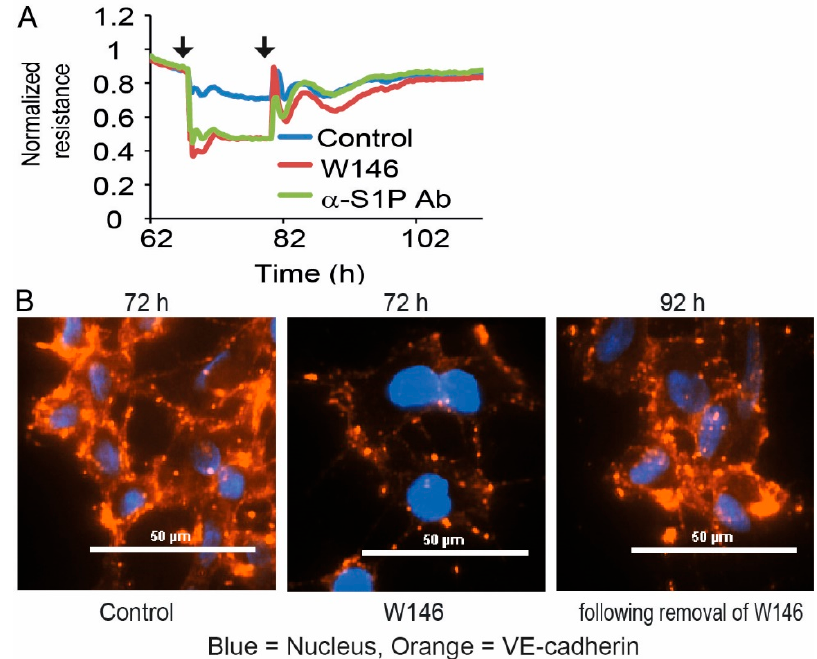
Figure 3. Dependence and reversibility of EC barrier stability in HUVEC and EA.hy926. ( A ) Resistance following treatment with 3 µ M S1PR1 antagonist W146 or 120 µ g / mL of anti-S1P antibody Sphingomab, followed by the removal of the added substances. Line plot represents one experiment out of three with black arrows indicating the addition and removal of W146 or Sphingomab at the corresponding time points. ( B ) Immunofluorescence staining of VE-cadherin in HUVEC after addition of 3 µ M S1PR1 antagonist W146, followed by removal of the added substance. Representative images from one out of three individual experiments are shown. Pictures were taken 6 h after addition of W146 and 12 h following removal of W146.